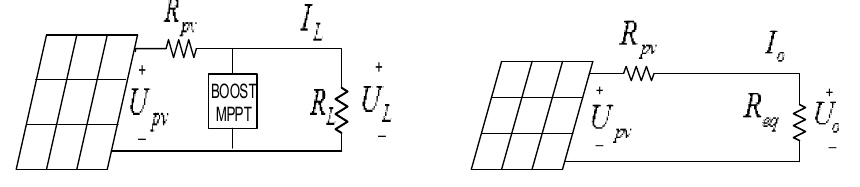
Figure 5. Boost conversion equivalent circuit.